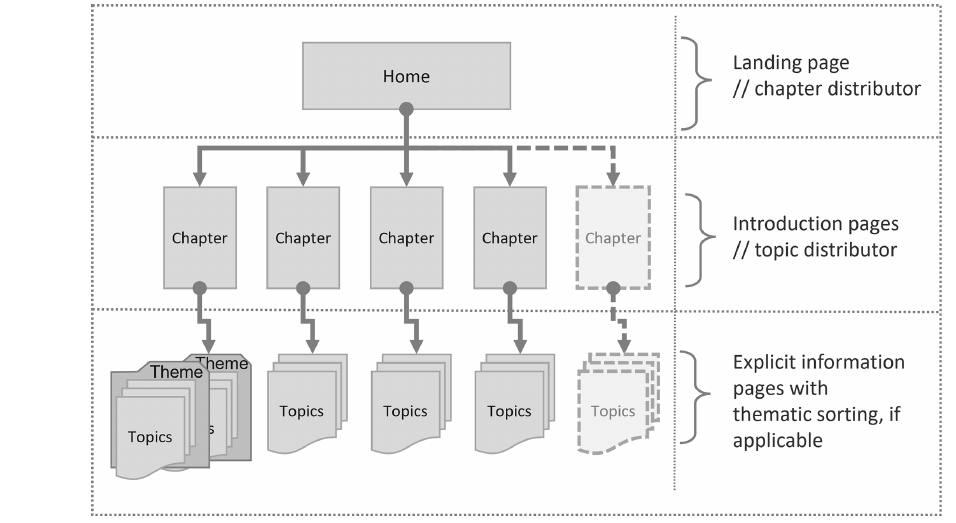
Figure 5. Technical target structure given to the project partners with the role of knowledge